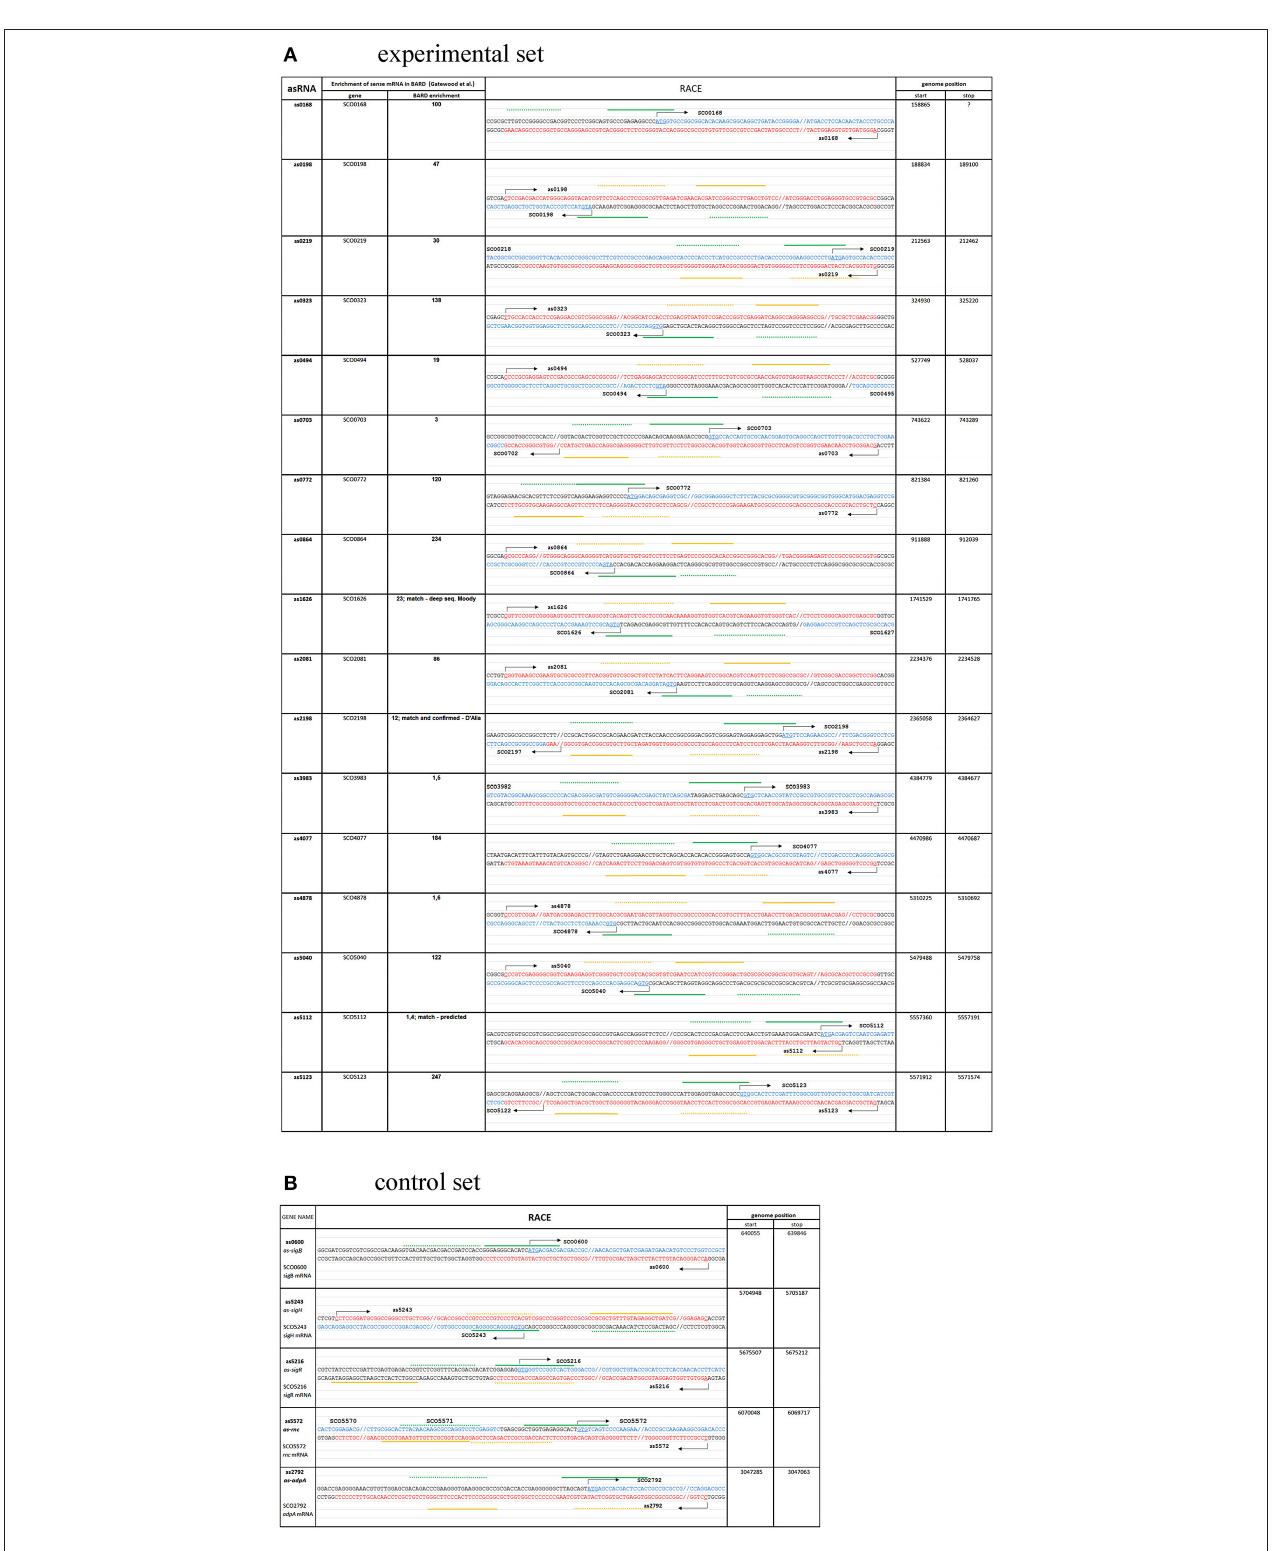
FIGURE 1 | Novel asRNAs revealed by 5 ′ and 3 ′ RACE method, and their genome locations (sequence of asRNA in red, sequence of mRNA in blue). Transcriptional start sites are indicated by arrows. Full green line represents 5 ′ RACE inner primers, dotted green line represents 5 ′ RACE outer primers, full orange line represents 3 ′ RACE inner primers, dotted orange line represents 3 ′ RACE outer primers. (A) Experimental set; (B) Control set; (see text for details).